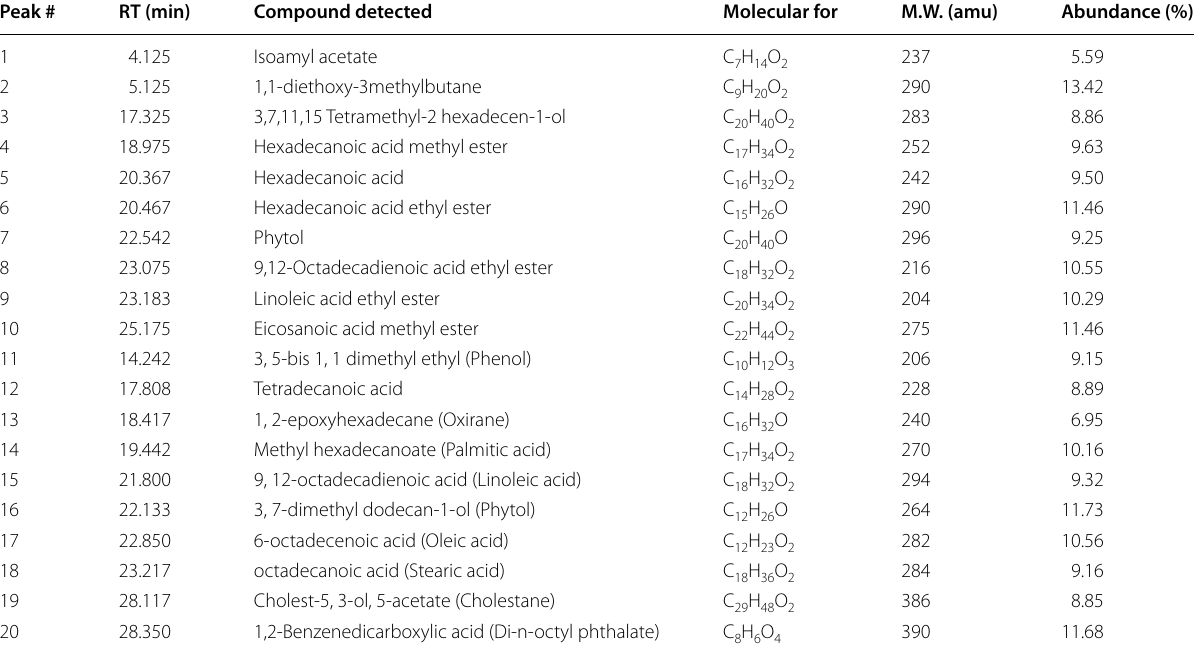
Table 5 Bioactive compounds of ethanol extracts of Vernonia amygdalina